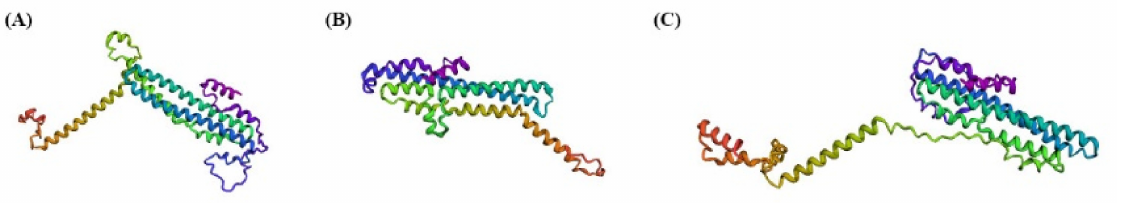
Figure 6. Predicted interaction network of SpSPX genes and their targets according to Arabidopsis. The interacted genes were connected by different lines.